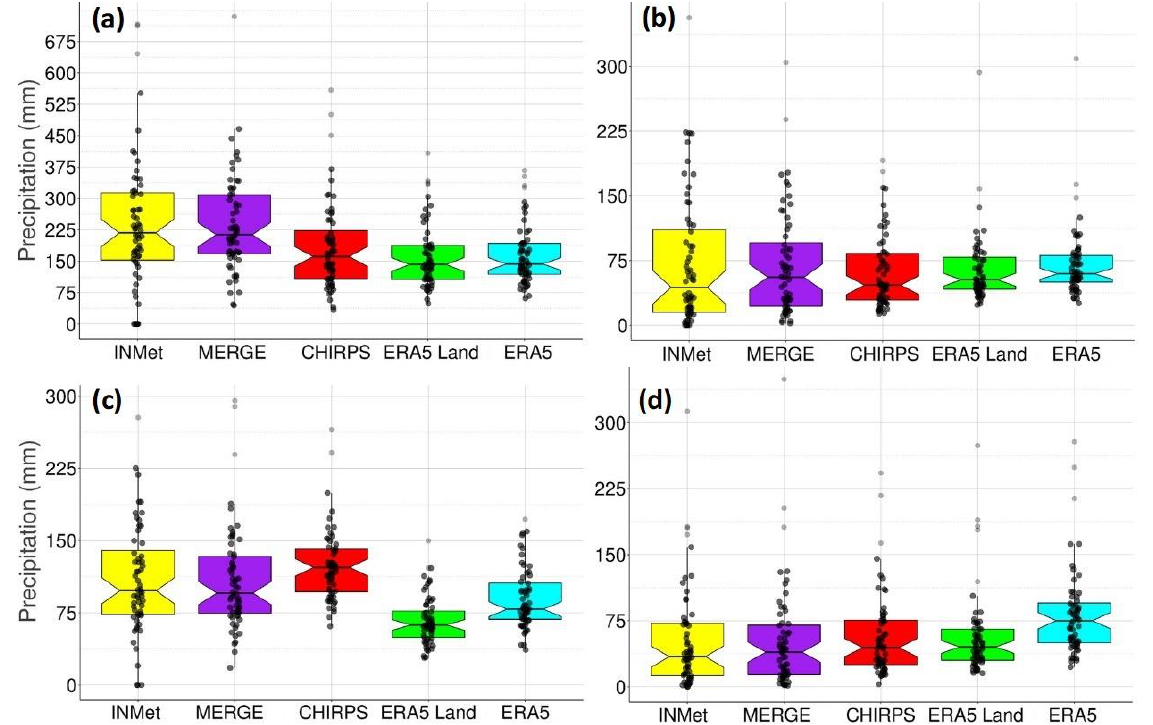
Figure 3. Comparison charts of the climate average between the observed precipitation (yellow) and data from MERGE (violet), CHIRPS (red), ERA5Land (green), and ERA5 (turquoise), for Maceió/AL (upper panel) in the winter ( a ) and in the summer ( b ) and for Alagoinhas/BA (lower panel) in the winter ( c ) and in the summer ( d ).